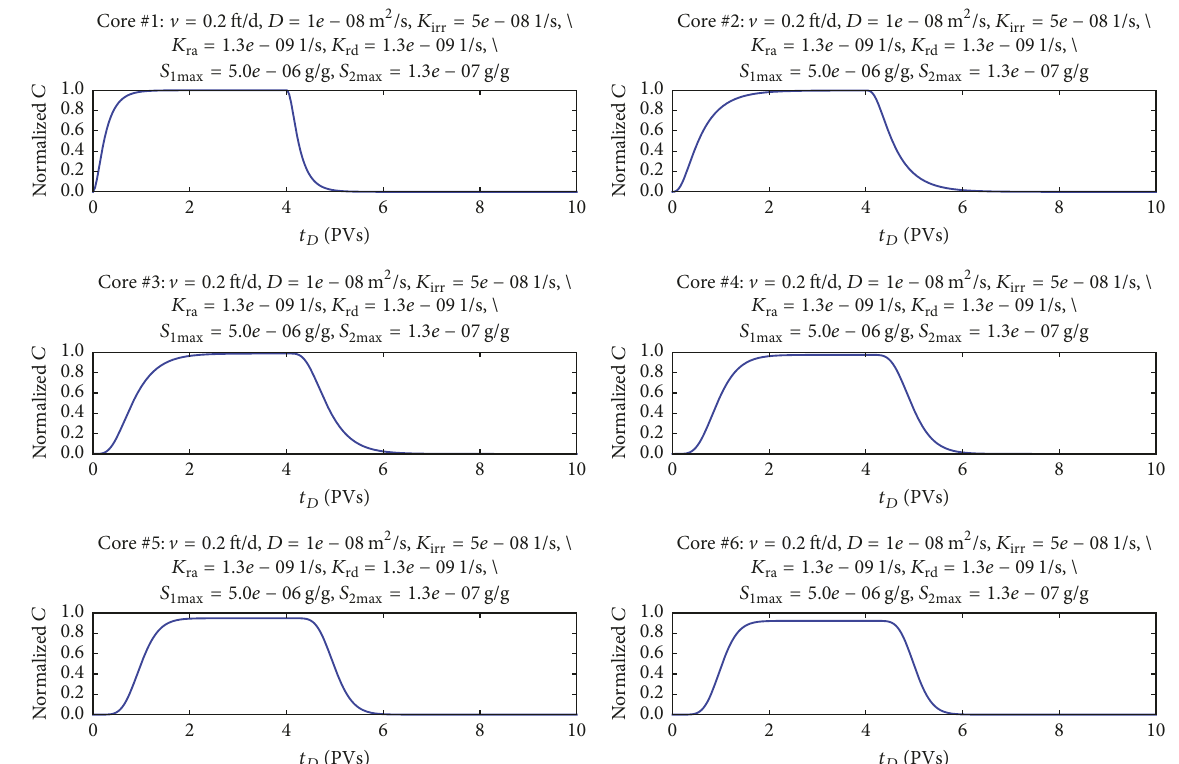
Figure 9: Effluent NP concentration for six cores at laboratory scale. The lengths of the six cores considered were 1, 2, 6, 12, 24, and 36 inches, respectively, with 1.5in width for all the six